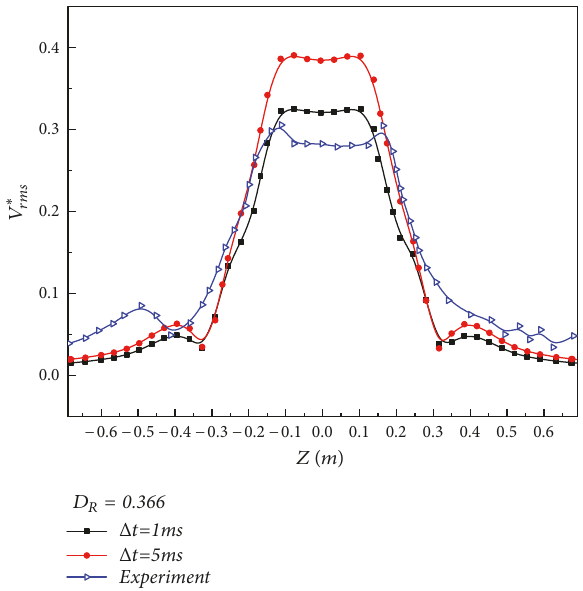
Figure10:ComparisonofdimensionlessRMStemperaturebetween the experimental value and the simulated value in different time